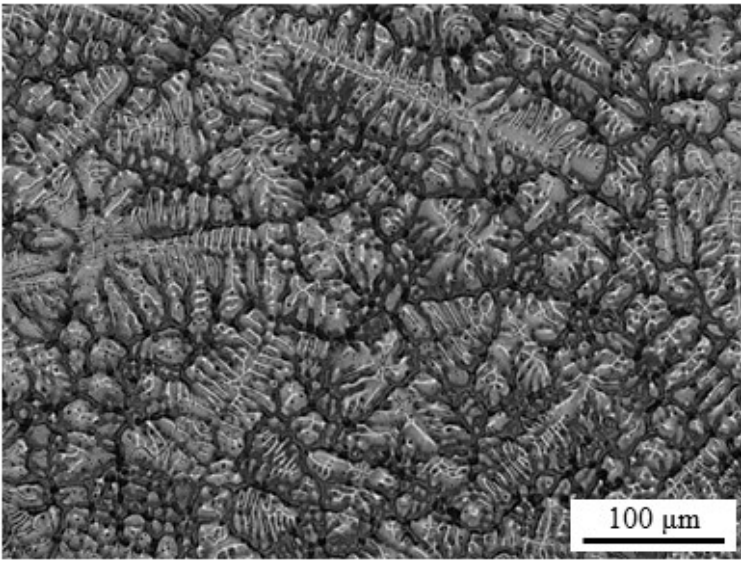
Figure1. Micrographofanas-castFe − 30Mn − 5Al − Figure 1. Micrograph of an as-cast Fe − 30Mn − 5Al − 0.5C twinning-induced plasticity (TWIP) steel specimen.